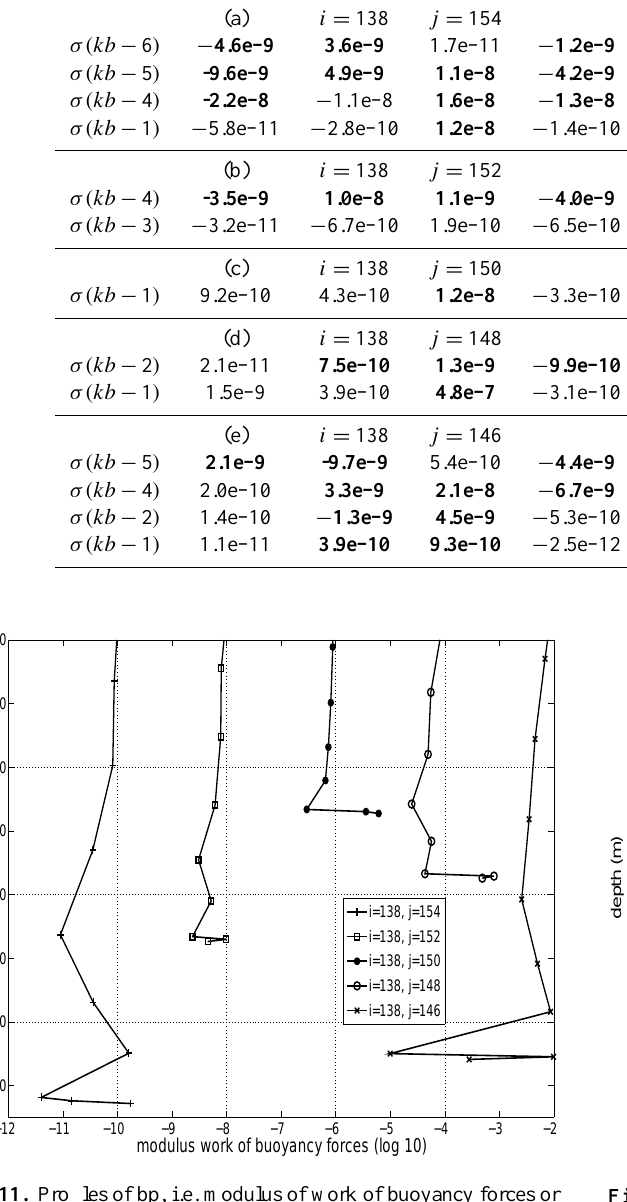
Fig. 12. Profiles of dp (m 2 s − 3 ), i.e. dissipation of q 2 . Profiles are offset as in Fig. Fig.12. Profilesofdp [ m 2 /s 3 ] , i.e.,dissipationof q 2 . Profilesareoffset asinFig.8.